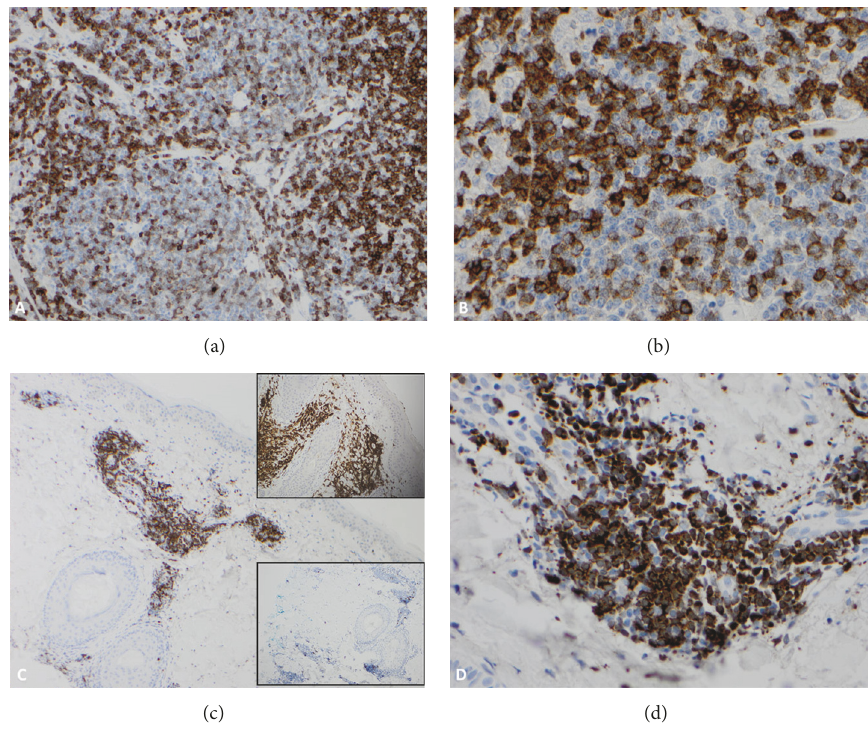
Figure 5: T-PLL involvement of lymph node (a, b) and skin (c, d). T-cells in the interfollicular areas are positive for TCL1 immunostain ((a), 200X and (b), 500X). T-cell aggregates in the dermis are positive for TCL1 ((c), 100X, (d), 400X). The insets in figure (c) show expression of CD3 (top) and lack of expression of CD20 (bottom) in neoplastic